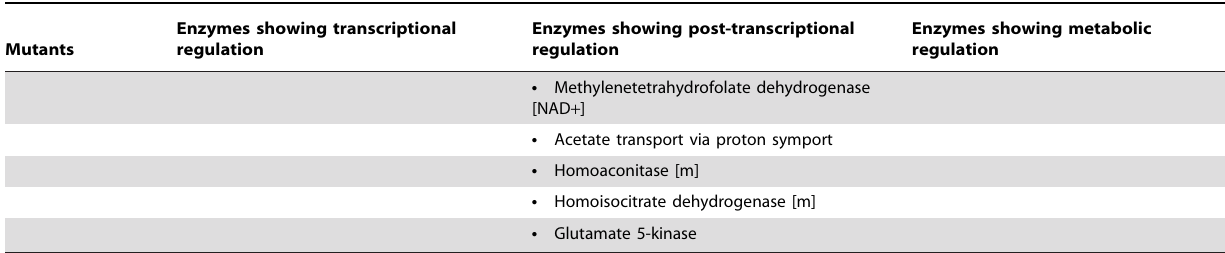
73 enzymes in the mentioned groups). For the hxk2 D strain the most significant transcription factor enrichment was found for the factors Pho2 (with 7 and 5 enzymes in each of the groups) and Bas1 (with 7 and 6 enzymes in each of the groups). and hxk2 D with respect to the wild type is due to a down-